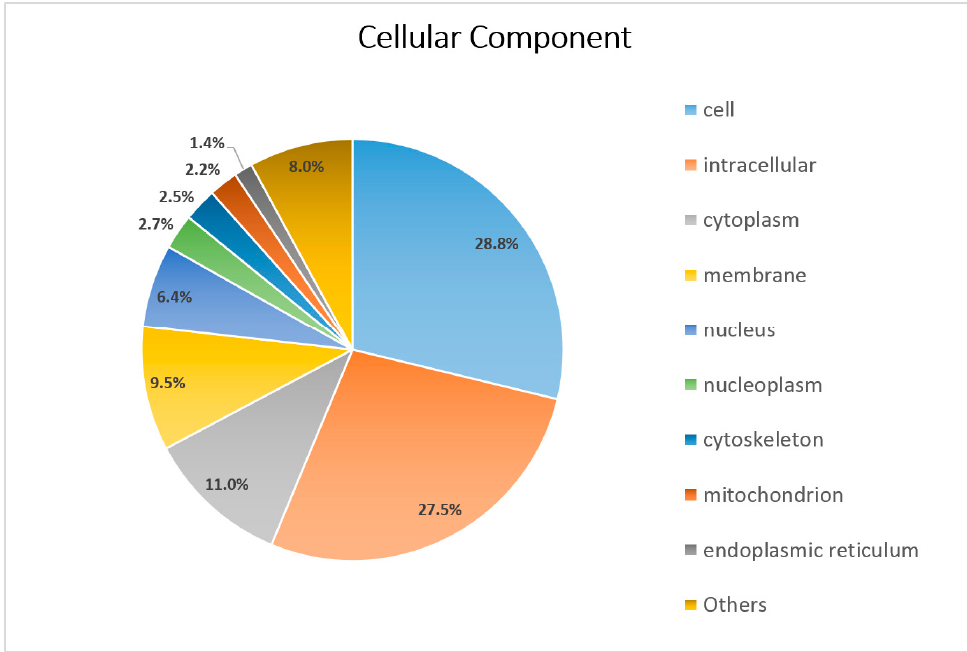
Figure 6. Subcategories of GOs identified by CateGOrizer within the Cellular Components over the whole set of predicted genes.